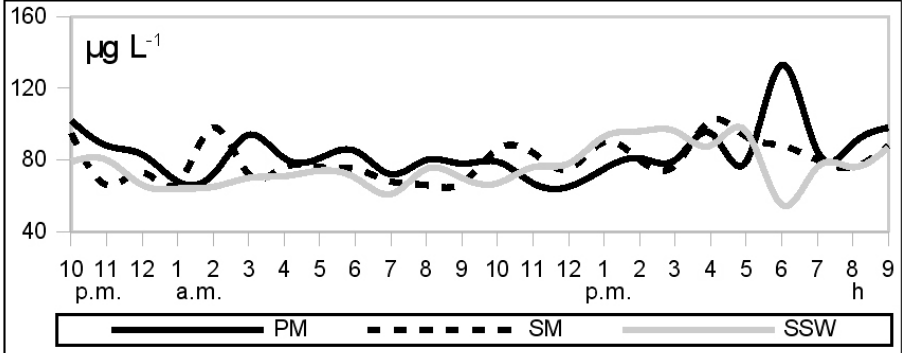
Figure 4. Diurnal variation in the concentration of dissolved phosphorus (µg L -1 ) in surface microlayers and subsurface water of Lake Dołgie